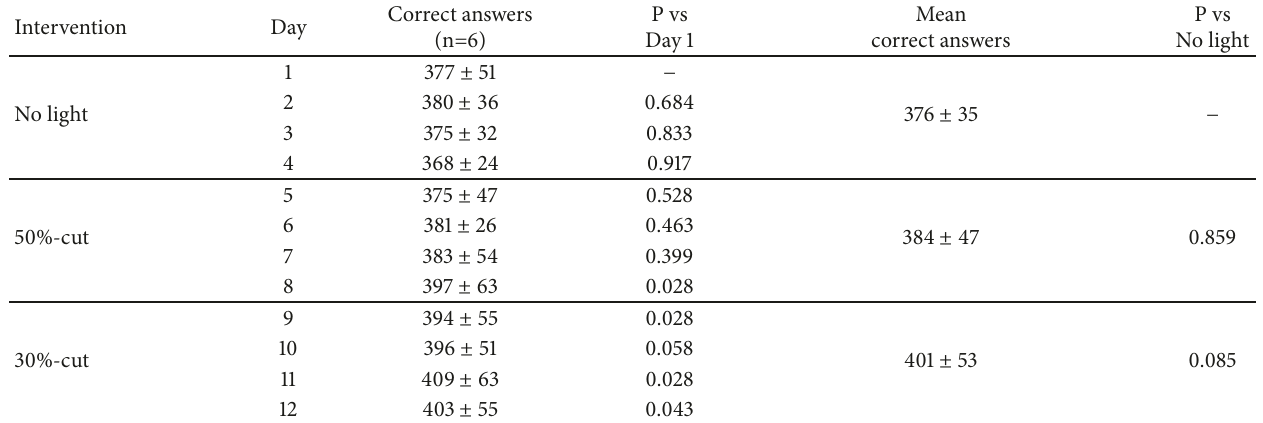
Table 3: Effects of the interventions on the number of correct answers in the calculation task across the study. Data are presented as mean ±